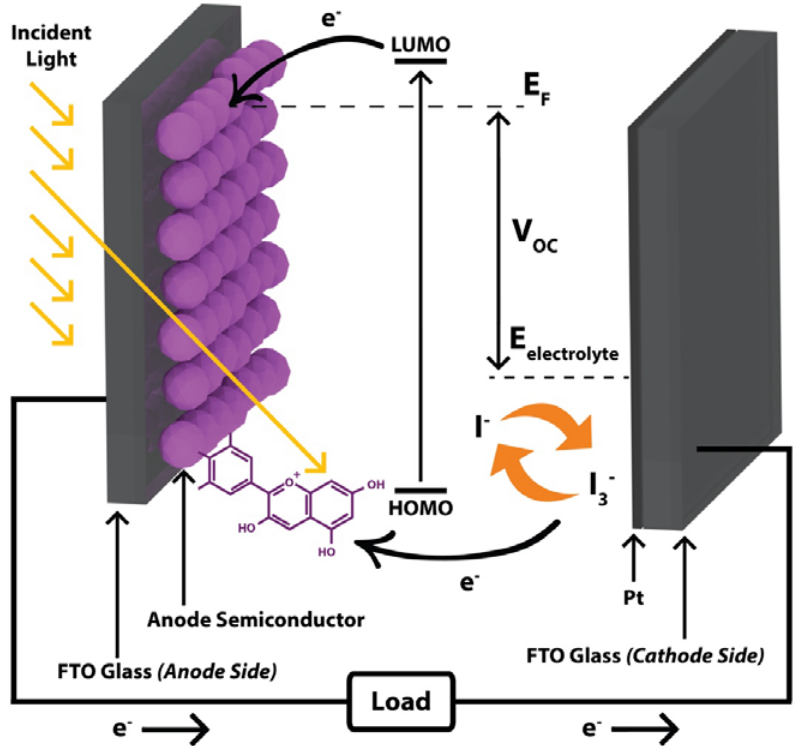
Figure 1. Schematic diagram of a dye-sensitized solar cell (DSSC) showing the major components and positions of relevant energy levels.